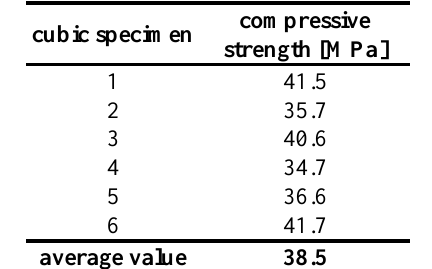
Table 1. Compressive test results (new bricks).